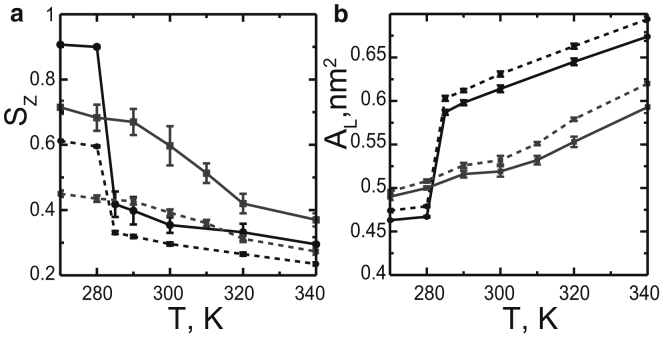
Chain orientational order parameter (a) and area per DPPC lipid (b) in the DPPC/DUPC 3:2 mixture (black) and the DPPC/DUPC/cholesterol 7:7:6 mixture (gray) are shown; solid lines correspond to the ordered clusters (see Methods), dashed lines to the averages in the bilayers.